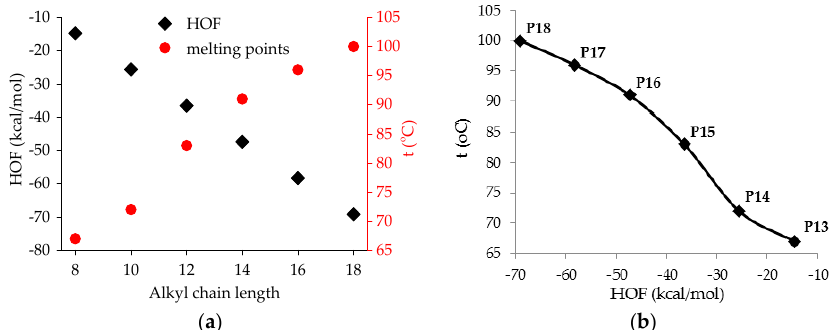
Figure 3. Plot ( a ) The relationships between calculated HOF and measured melting points vs. the length of the hydrocarbon chain of compounds P13 – P18 ; Plot ( b ) The correlation of melting points vs. HOF of P13 – P18 .